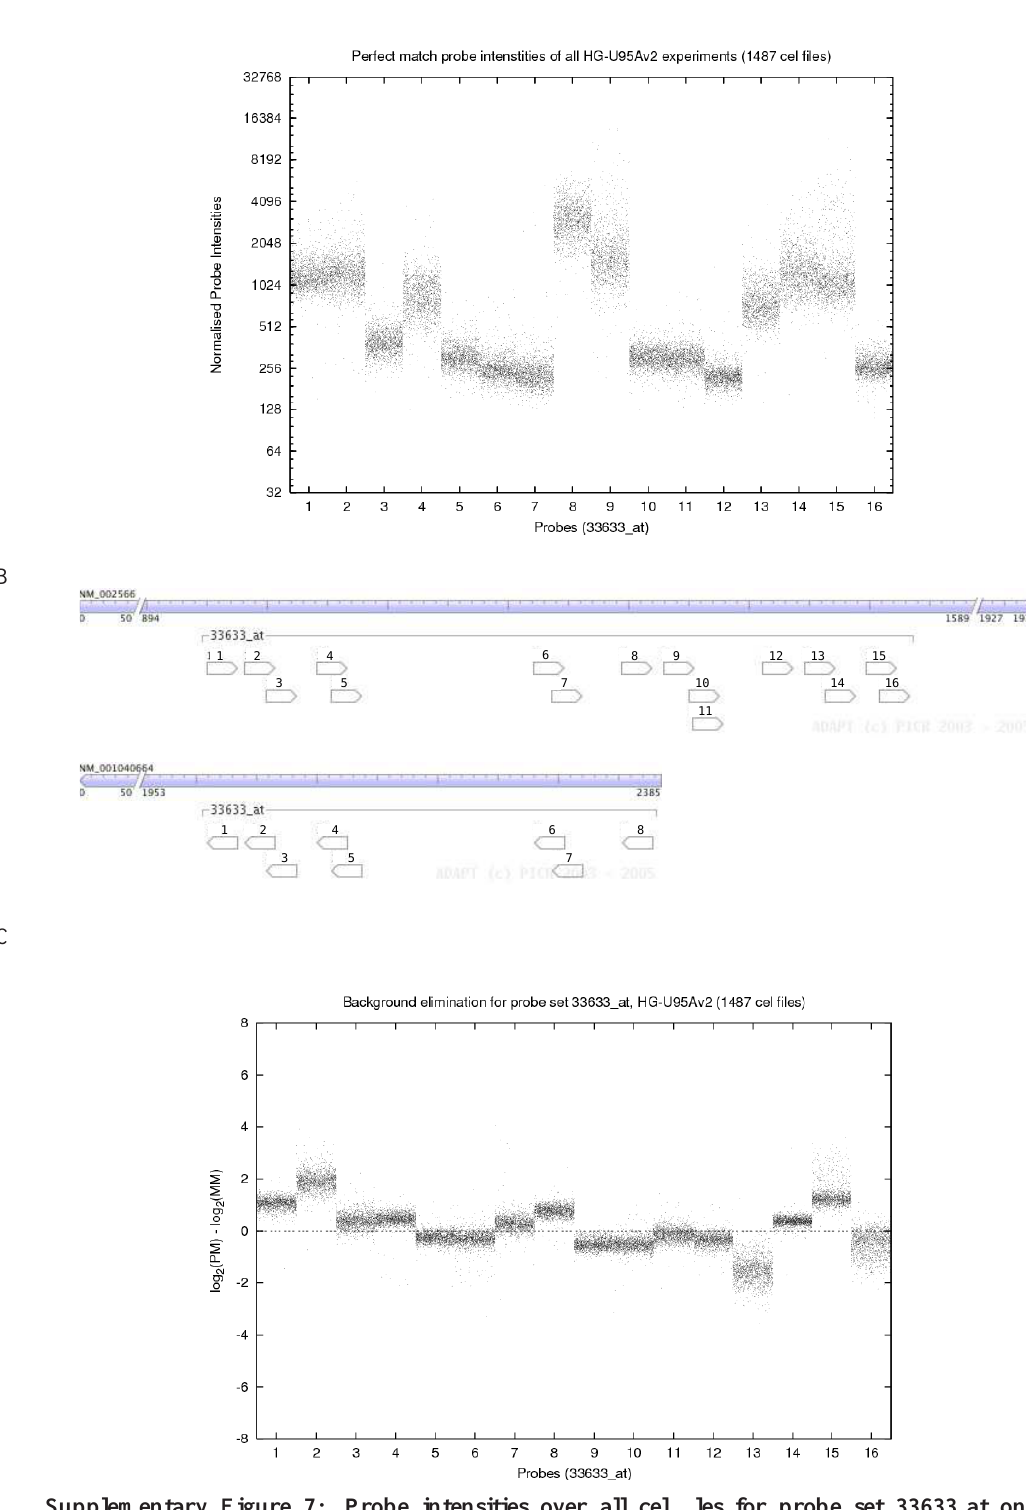
Supplementary Figure 7: Probe intensities over all cel files for probe set 33633 at on the HG U95Av2 array (A) Perfect match intensities (log scale) (B) ADAPT probe positions on the transcripts (C) Background elimination (log 2 (PM) - log 2